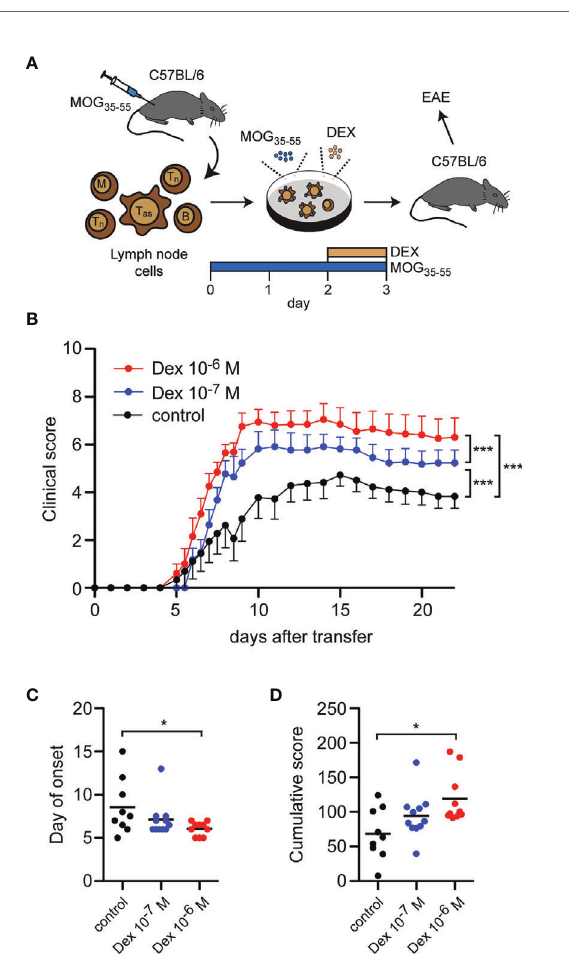
FIGURE 6 | Enrichment of antigen-primed effector T cells after GC treatment in vitro aggravates clinical symptoms in an adoptive transfer EAE model. (A) Setup of the experimental model. (B-D) EAE development after transfer of 2.5 x 10 6 T cells under control conditions (black) or after treatment with 10 -7 M (blue) or 10 -6 M (red) Dex for the last 24 hrs of the cell culture period in vitro . Clinical score of all mice that became sick, depicted as the mean +/- SEM (B) , the day of disease onset (C) , and the cumulative clinical score (D) are depicted. N = 11-13. Statistical analysis was performed by One-way ANOVA followed by a Newman-Keuls Multiple Comparison test. Levels of signi fi cance: *p < 0.05; ***p <